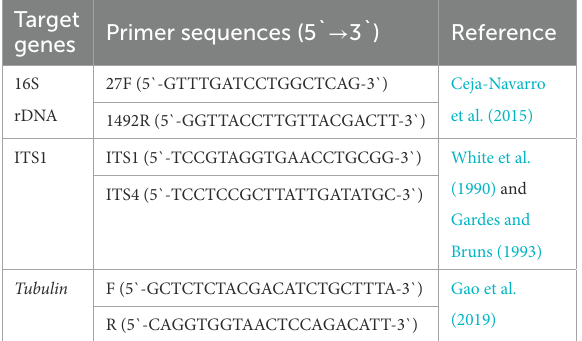
TABLE 1 PCR primers for germ-free BSFL (GF) and gnotobiotic BSFL (GB) validation. Target